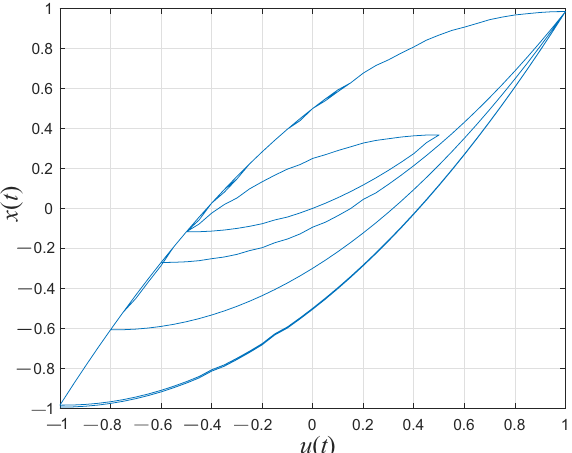
Figure 5. Characteristic curve of the Preisach